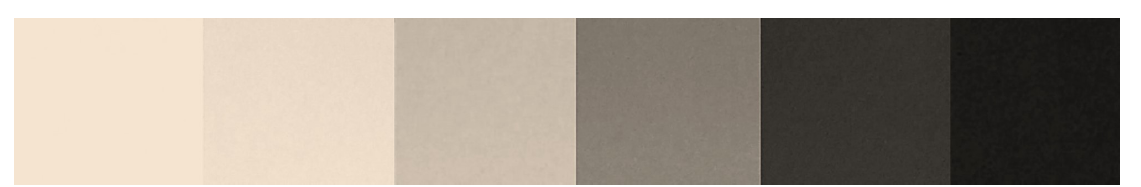
Figure 4. Gray level test target